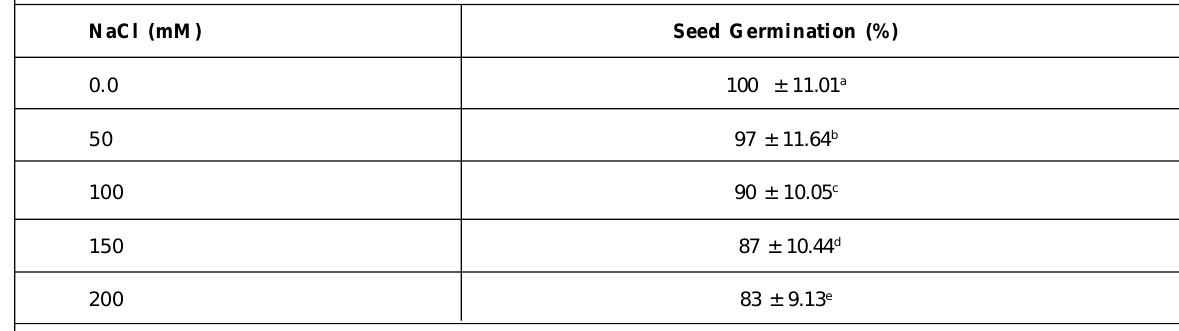
Table 1: Impact of different concentrations of NaCl on the percentage of seeds germination in Phaseolus vulgaris L.